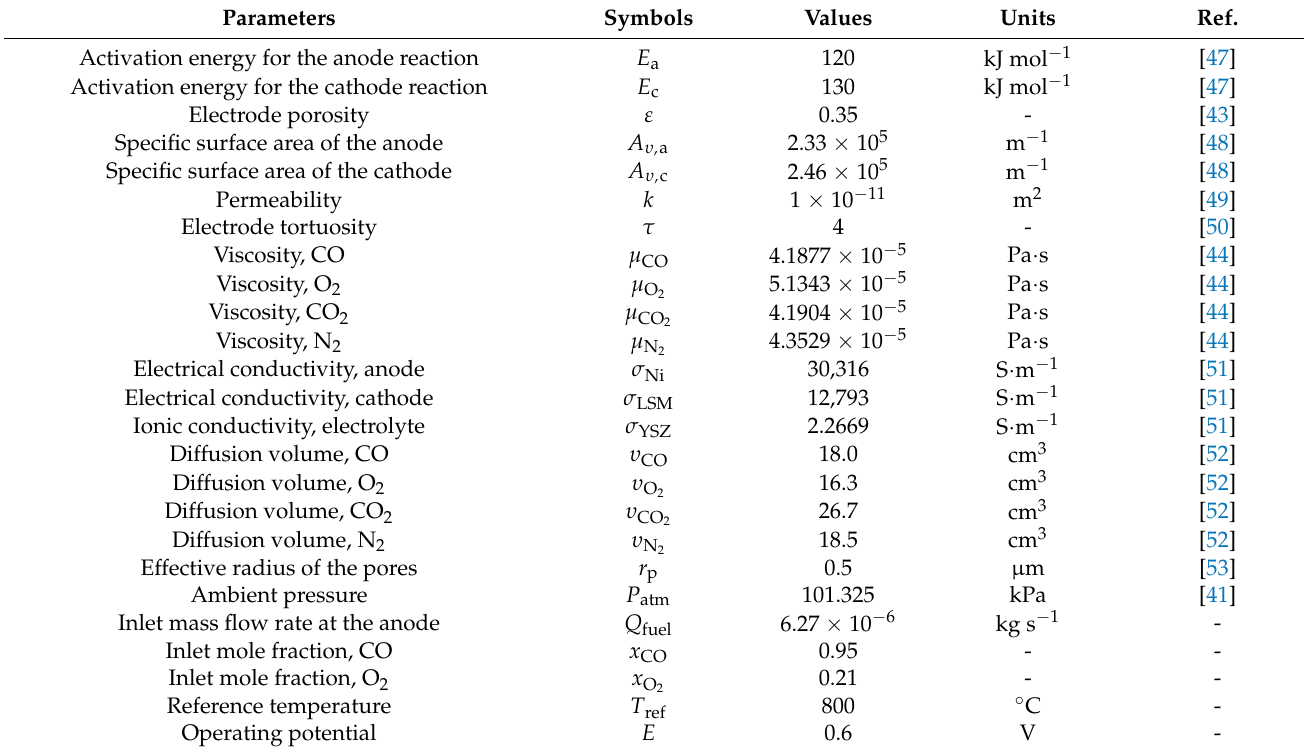
Table 2. A summary of parameters used in this